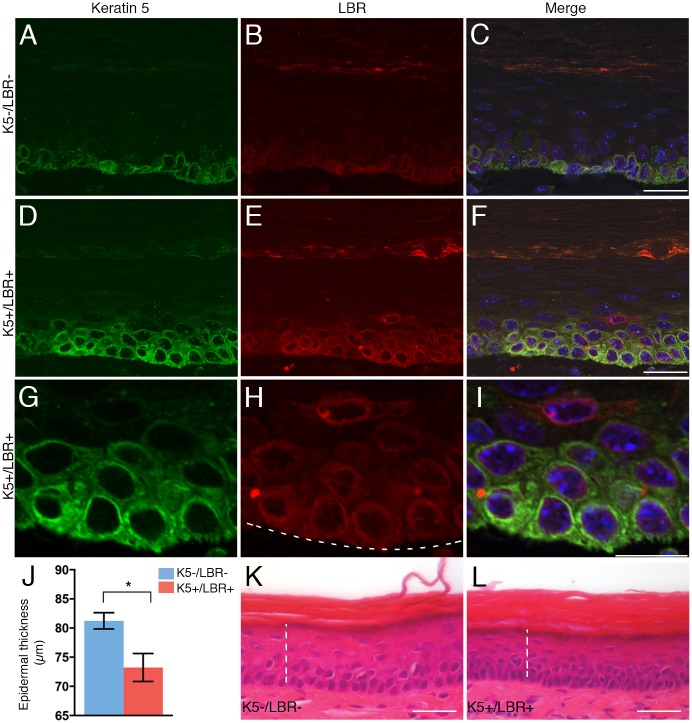
Overexpression of LBR results in hypoplasia of paw epidermis.A-I. Immunofluorescence of plantar paw with LBR (red), keratin 5 (green), and DNA (blue) in 8-week-old K5-/LBR- (A-C) and K5+/LBR+ mice (D-F). Normal expression of LBR in the basal cell layer and a few suprabasal cells (B). LBR overexpression and upregulated keratin 5 expression in basal and suprabasal keratinocytes (G-I). J-L. Measurement of the thickness of the paw epidermis in week-8 K5-/LBR- (blue) and K5+/LBR+ (red) mice. Dashed lines indicate region for measurement of epidermal thickness (basal cell layer to stratum granulosum) in K5-/LBR- (K) and K5+/LBR+ (L) mice, with at least 5 measurements per sample. Error bars indicate SEM (* p<0.05). Scale bars indicate 20 μm (C, F) and 10 μm (I).